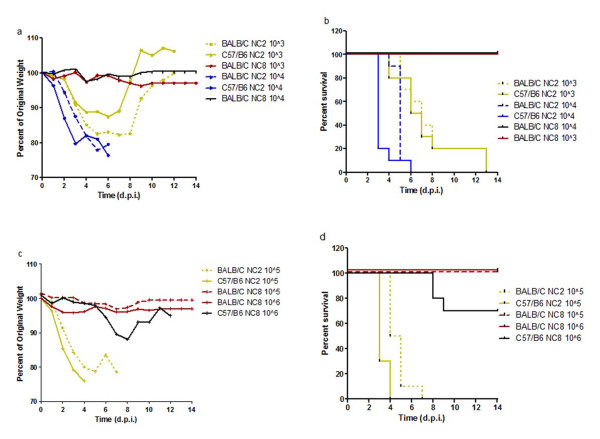
Analysis of biological heterogeneity in different mice strains in dose dependent manner. Pandemic H1N1 viruses (NC2 and NC8) were compared in C57/BL6 and BALB/C mice in dose dependent manner. Weight losses (a, c) and lethality (b, d) are shown for animals (n = 10/group) infected with varying concentrations of viral strains (103, 104, 105 and 106). Log rank sum test shows significant differences in mortality curves between NC2 and NC8 irrespective of inocula and mice strain (P < 0.0001). ). (a, c): Inter-group comparisons in weight loss shows significant difference NC2 vs NC8 groups (P < 0.0001), C57/BL6 vs BALB/C; NC2_ 104 (P < 0.0001), NC2_105 (P < 0.0001). (b, d): Survival differences are also significant in C57/BL6 vs BALB/C after NC2 infection: 104 (P < 0.0028), 105 (P 0.0005), 106 (P 0.0669).